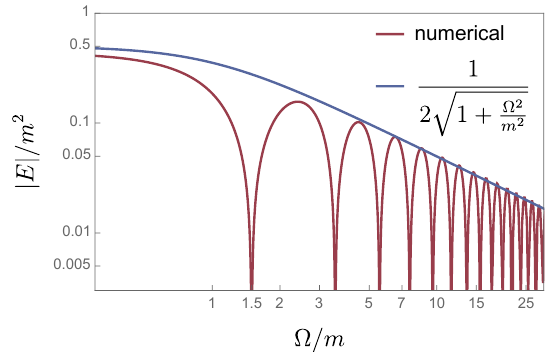
Figure 3 . Logarithmic version of the plot in (cid:12)gure 2. The high (cid:10) =m (cid:12)tting is derived in section C.3 (see eq. (C.43)).